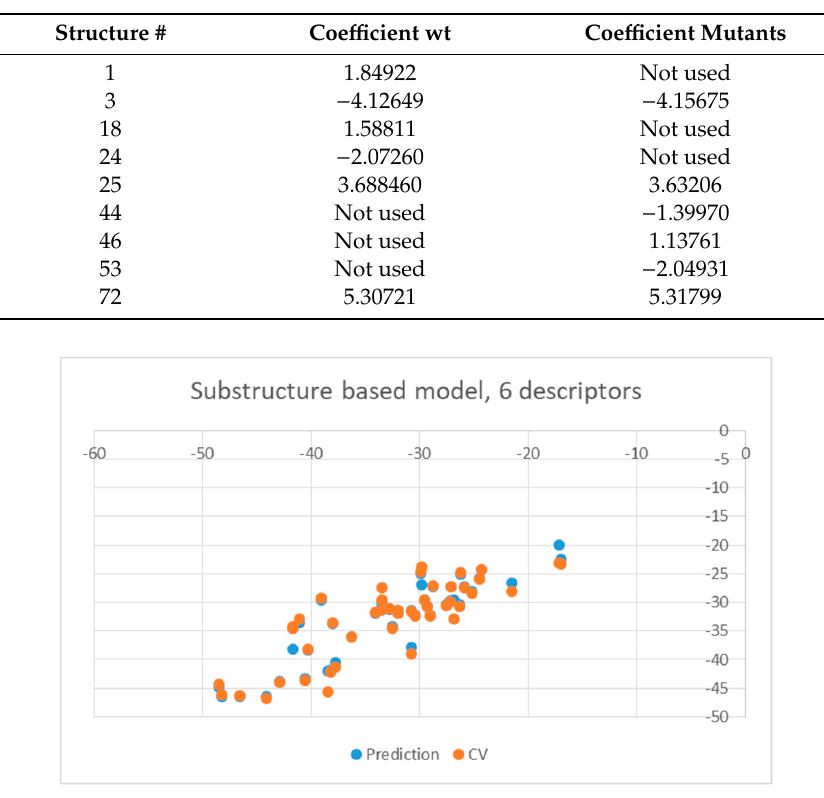
Table 4. Weight vector normalized coe ffi cients of the substructure-based QSAR models.